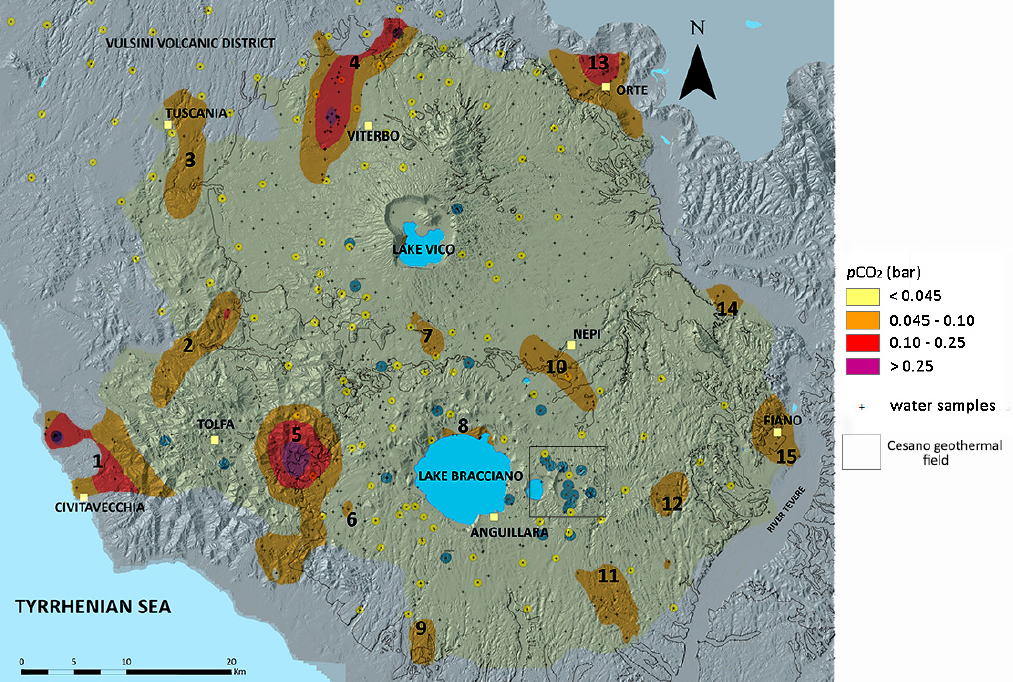
Figure 5. Map of p CO 2 distribution as obtained from ordinary kriging after back-transformation. The